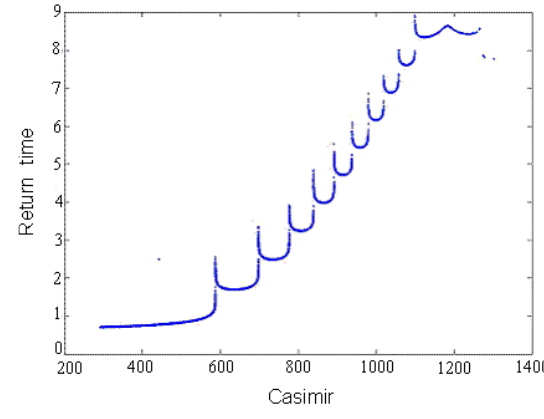
Fig. 3. Return times as a function of Casimir. Figure from Pelino and Maimone (2007), copyright American Physical Society.